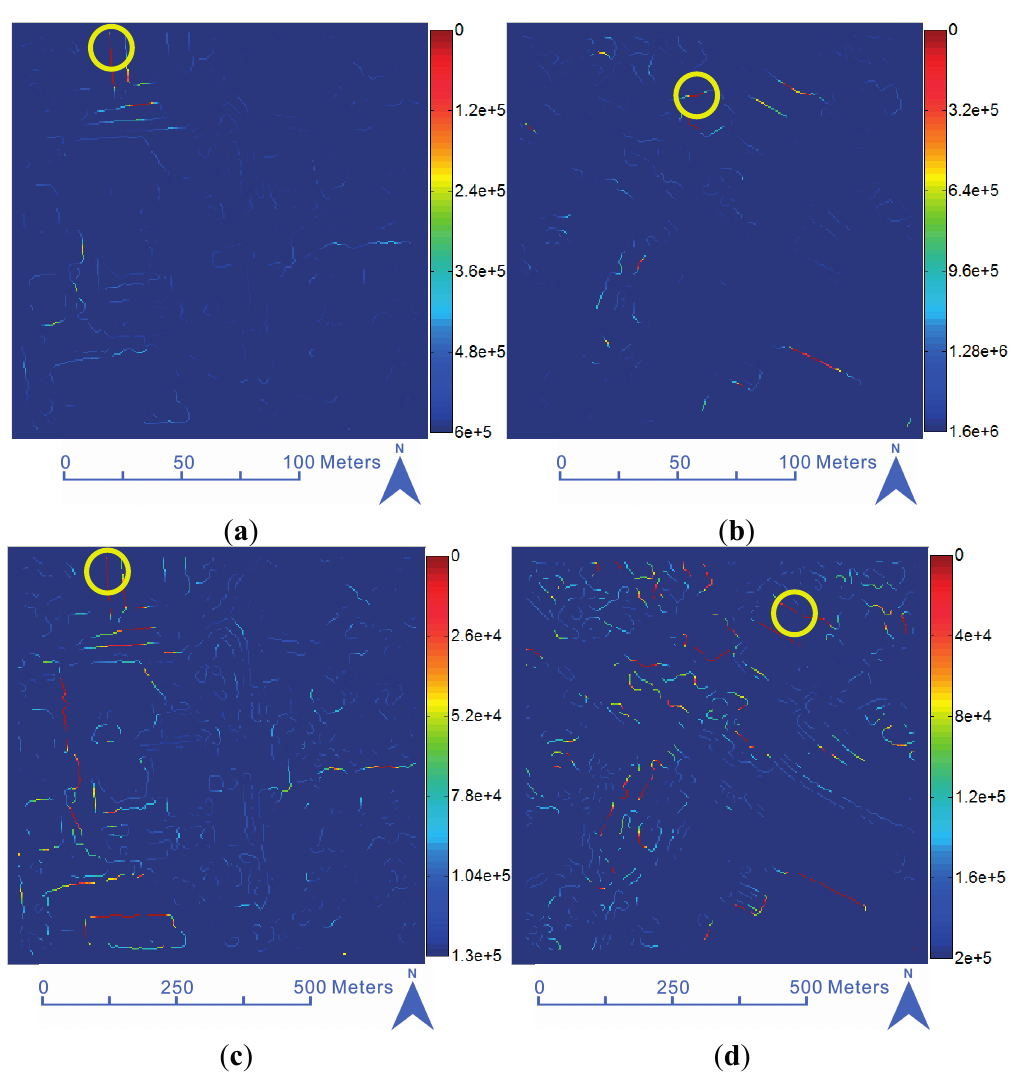
Figure 10. The kurtosis maps for the degraded images after the small-scale and large-scale coding processes. Lower kurtosis means higher contrast and more homogeneous textures on both sides of an edge. ( a – d ) are the results of Figures 5–8a, respectively. Regions highlighted by circles are the centers of the best knife edges, centered at (70,17), (136,52), (70,17), and (193,63),